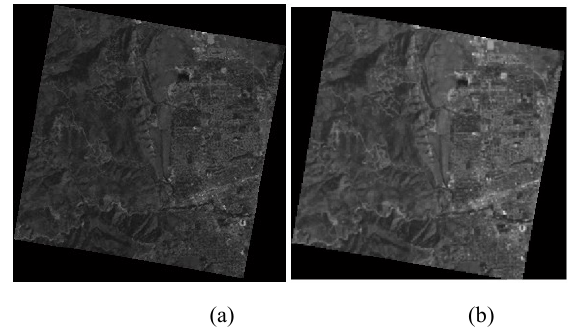
Figure 13. Comparison with different interpolation methods. (a) Nearest neighbour interpolation. (b) Bilinear interpolation.